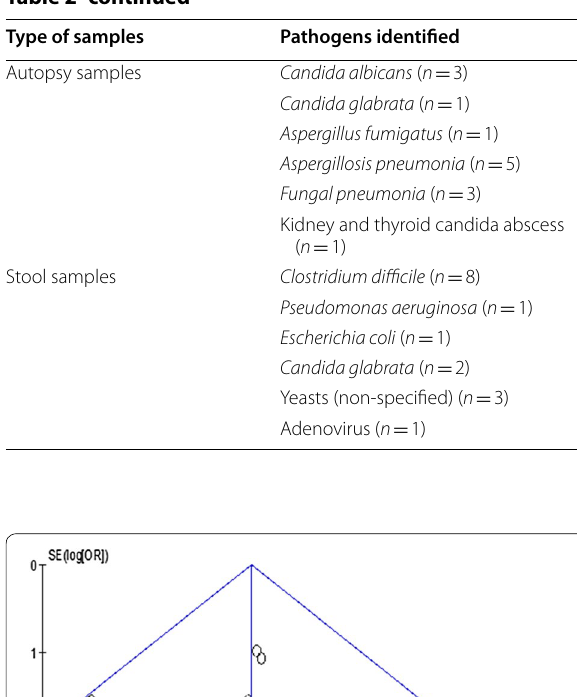
Table 2 Microbial documentation reported in the selected